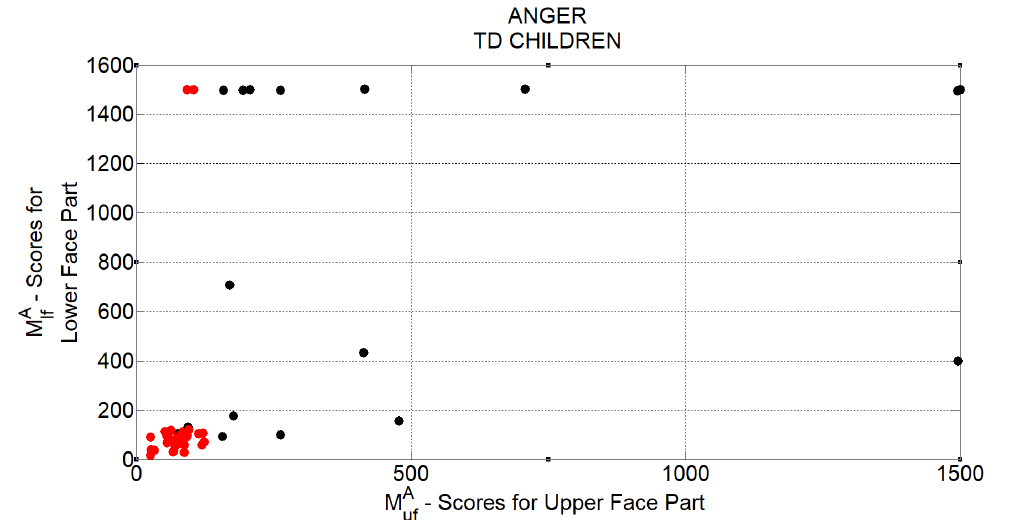
Figure 5. Scores computed for the production of Anger expressions by TD